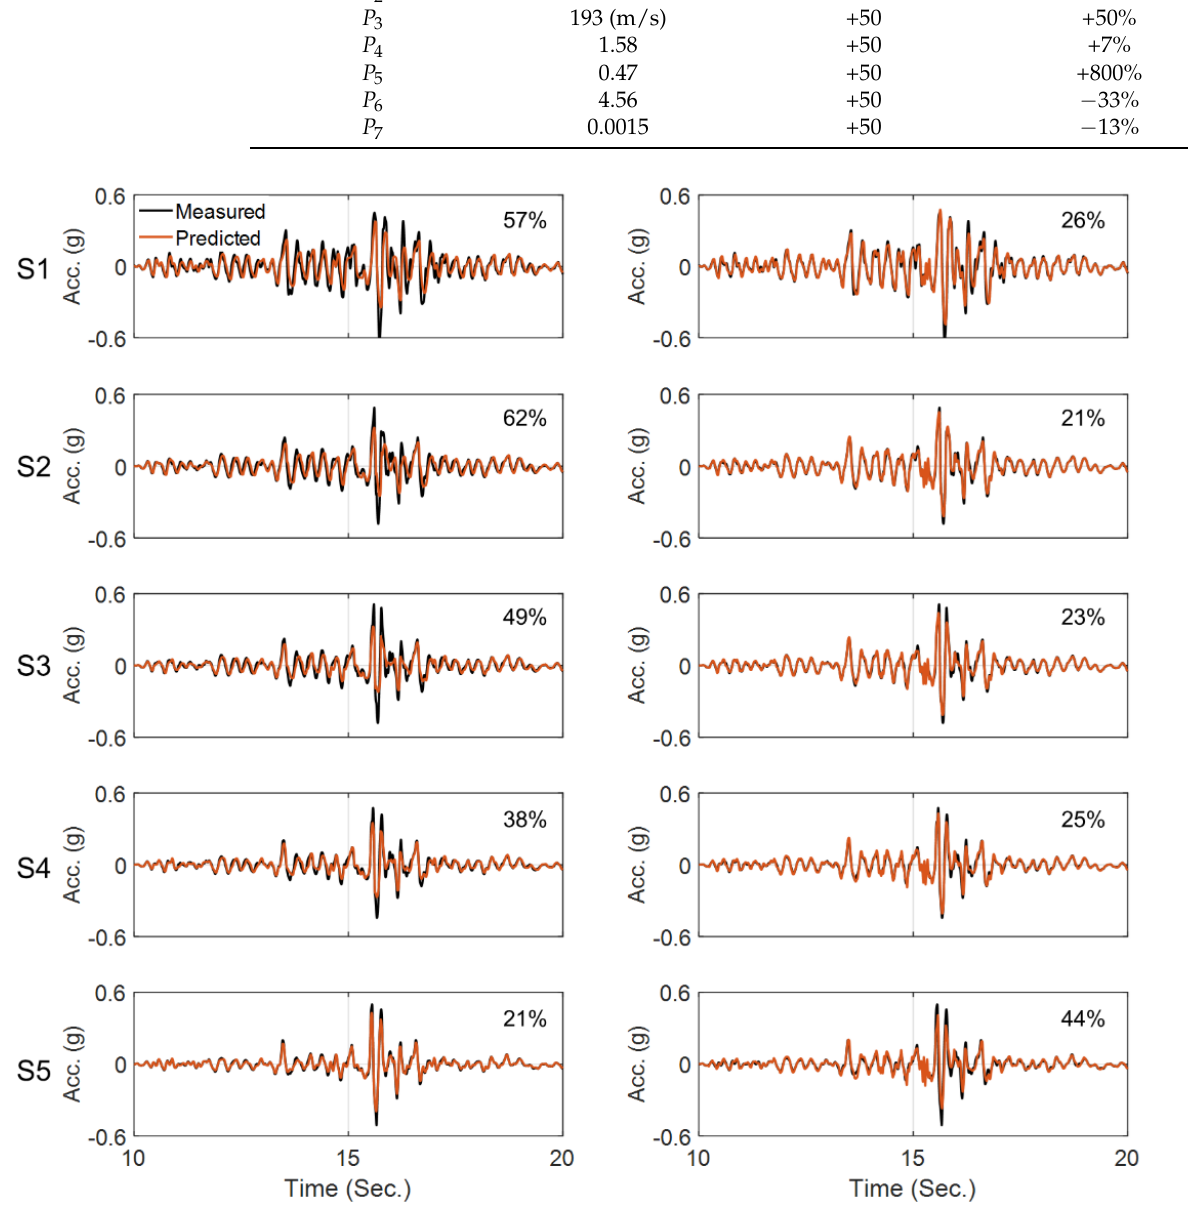
Figure 16. Comparison between recorded and predicted acceleration responses at five top sensors using baseline ( left ) and identified ( right ) model parameters. Table 4. The baseline value and initial and final errors of estimation parameters for the centrifuge experiment case study.